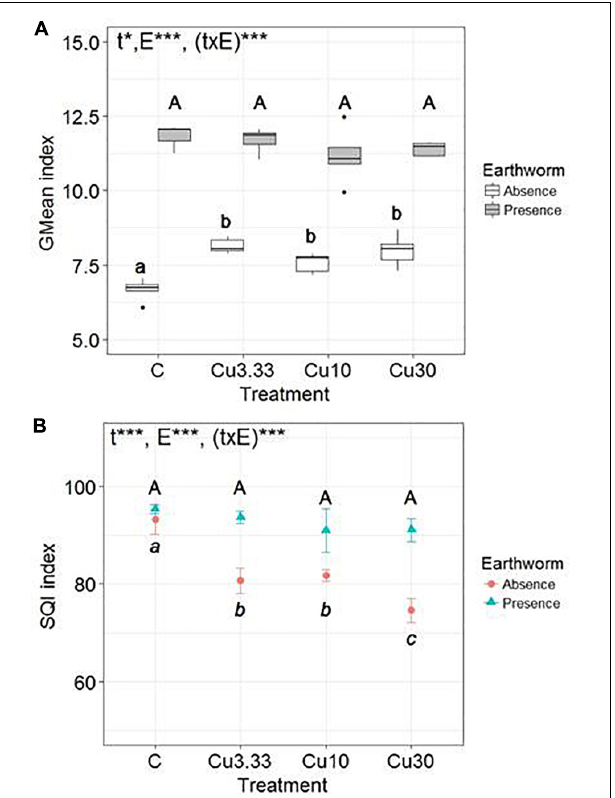
FIGURE 1 | Box-plots of (A) the geometric mean (GMean index) and (B) the Mean values ( n = 5, ± SD) of the Soil Quality Index (SQI) of microbial activities ( β -D-glucosidase, phosphatase, urease and arylamidase, potential nitrification activity) in soils spiked with different Cuprafor Micro R (cid:13) concentrations (3.33, 10, and 30 times the RD, corresponding to 25.8, 77.5, and 232.5 mg kg − 1 of copper, abbreviated Cu3.3, Cu10, and Cu30, respectively), and a control, in the presence or in the absence of earthworms. Different letters mean significant differences between treatments and the results of the two-way ANOVA test are presented as follows: “t” is for treatment effect, “E” for earthworm effect, and “(txE)” for their interaction. “ns” means no significant difference, ∗ p < 0.05 and ∗∗∗ p <